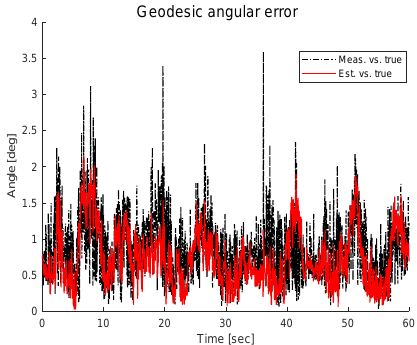
Figure 9: The black plot shows the measured geodesic distance between the measured rotation ma- trices and the true attitudes over time. The red plot shows error angles between the esti- mated attitudes, based on vision data only, and the true rotation matrices.